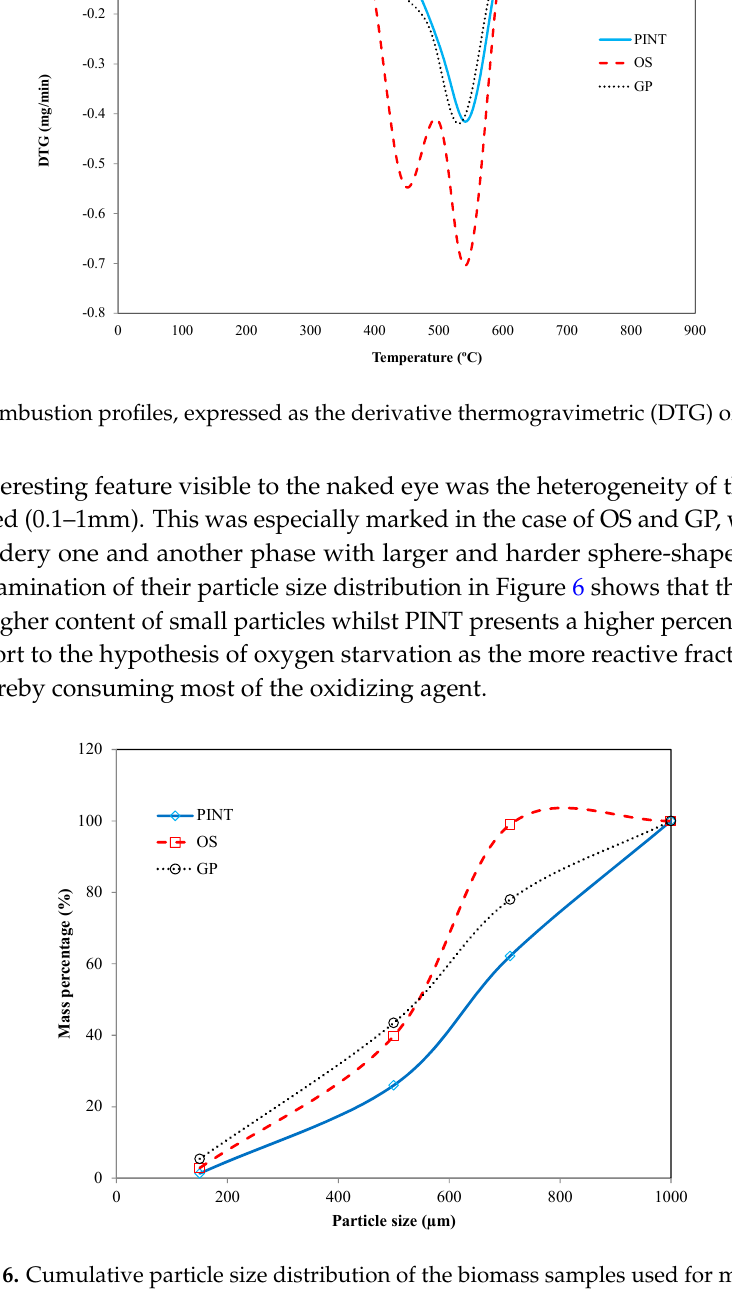
Figure 4. Results of the syngas composition ( a ) (CO + H 2 ), ( b ) gas yield and ( c ) cold-gas efficiency of the biomass mixtures.